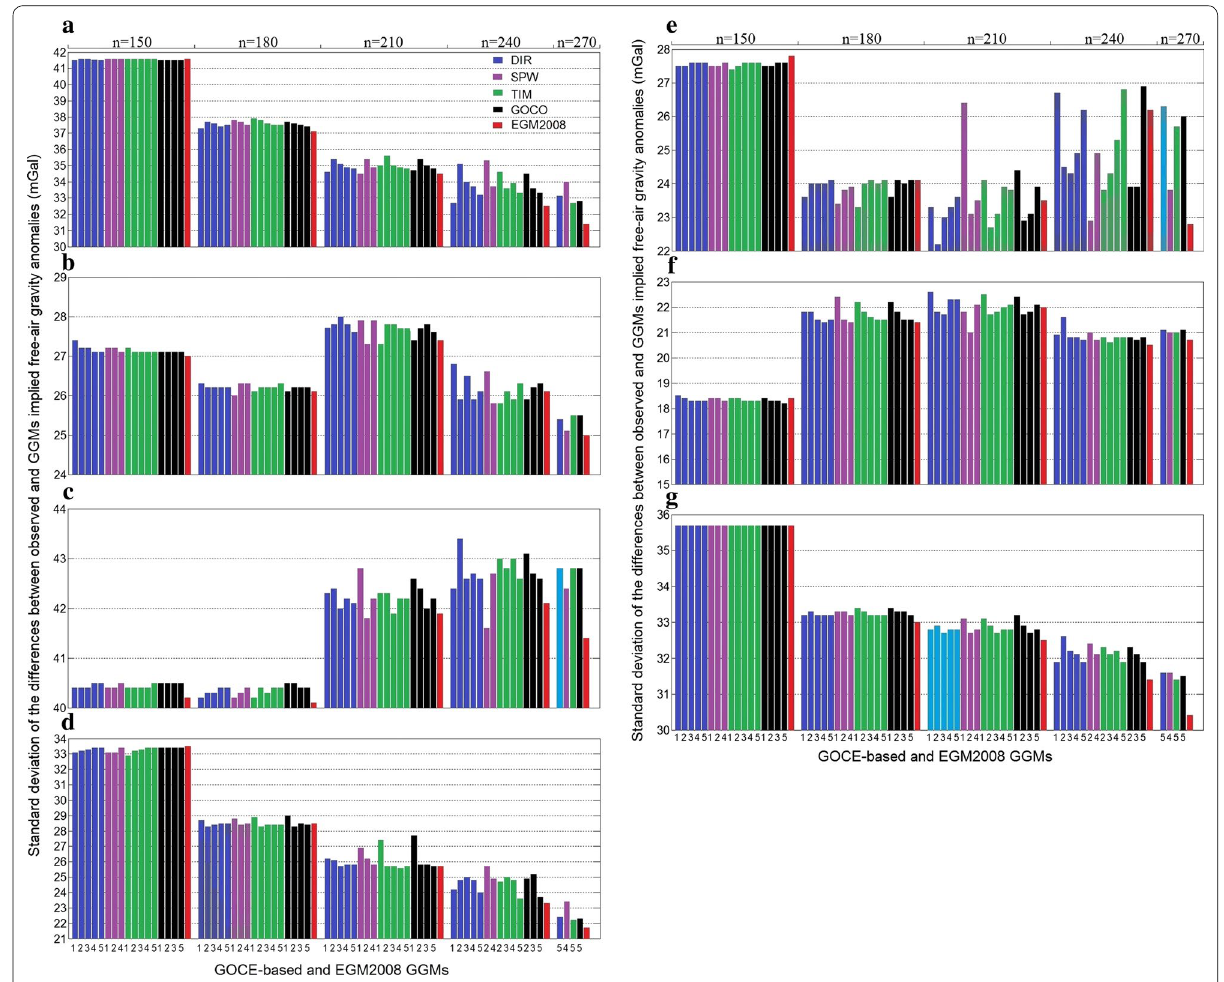
Fig. 2 Standard deviations of the differences between observed and GGMs implied free-air gravity anomalies over— a Hokkaido, b north Honshu, c central Honshu, d west Honshu, e Shikoku, f Kyushu and g Japan. n represents the spherical harmonic